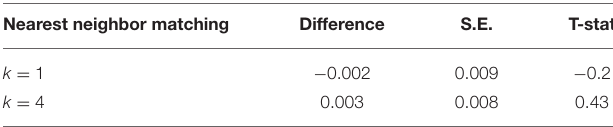
TABLE 4 | Conditional independence assumptions test results for pseudo treatment. Nearest neighbor matching